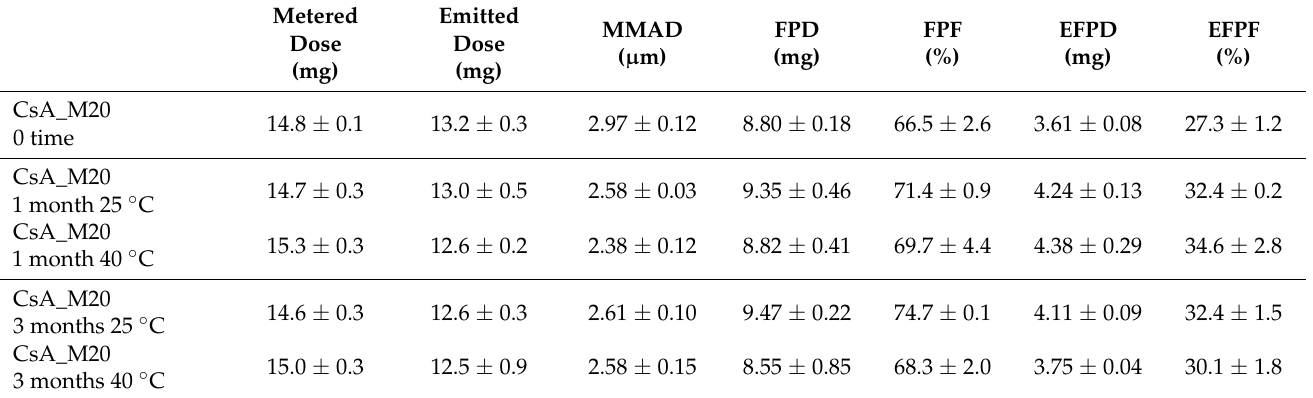
Table 4. Aerodynamic characterisation of the CsA_M20 powder at time zero and during the stability investigation in standard and accelerated conditions (n = 3, mean value ±